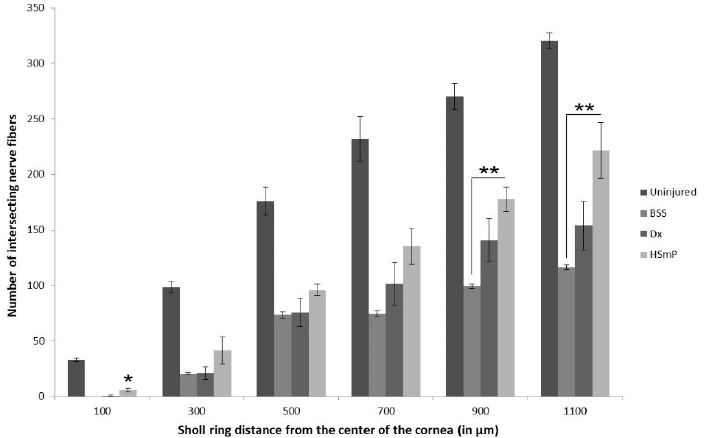
Figure 6. The graph shows the number of fibers intersecting Sholl’s rings at each distance point. (* = p < 0.05; ** = p < 0.01). Differences for uninjured corneas compared to the rest of the groups were omitted from the graph. They were p < 0.001 with Dx and BSS at all distances. Differences between